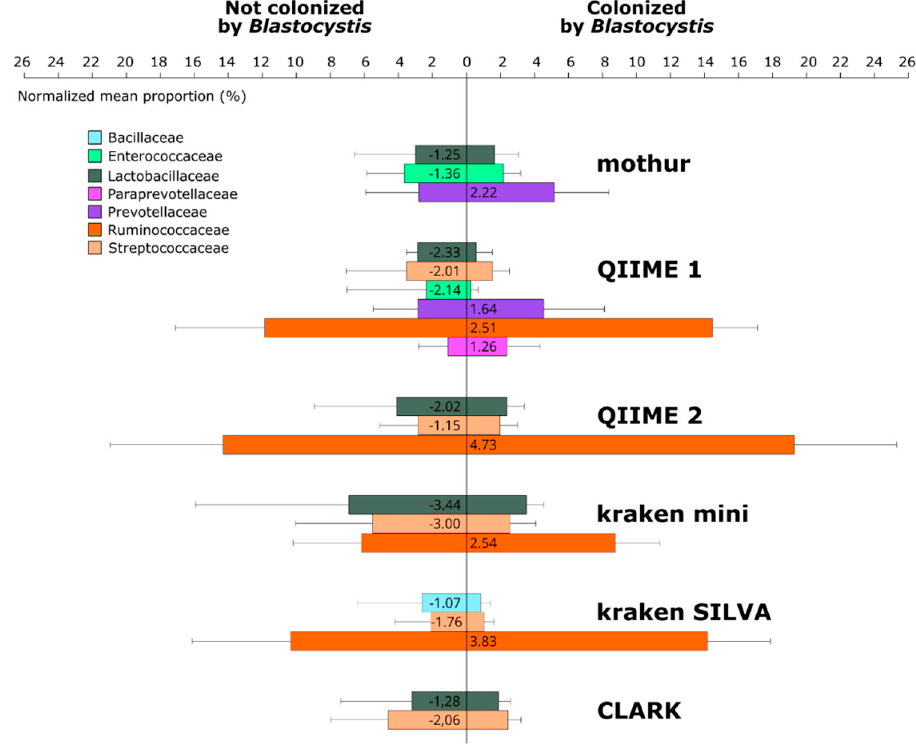
Figure 3. Mean proportions of each family are significantly different between both groups (the difference between groups has been tested reproducing the original study secondary analysis: using a non-parametric Student test with a Benjamini-Hochberg correction; only the families with a q -value < 0.05 and an effect size above 1% have been represented). Values on each bar is the difference of means between both groups.